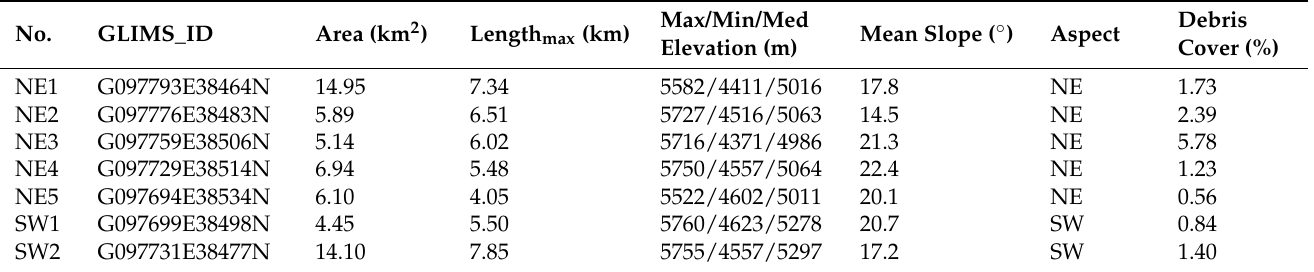
Table 3. Basic attributes of the STGs in this study. All attributes are obtained from the Randolph Glacier Inventory